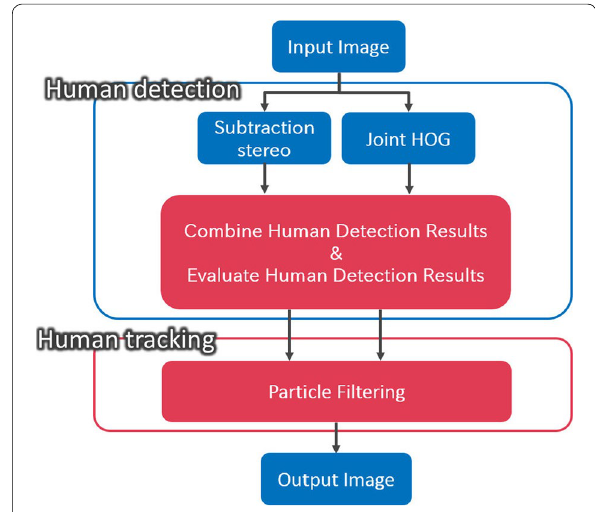
Fig. 1 Overview of proposed method. The figure represents flow of detection and tracking of the proposed